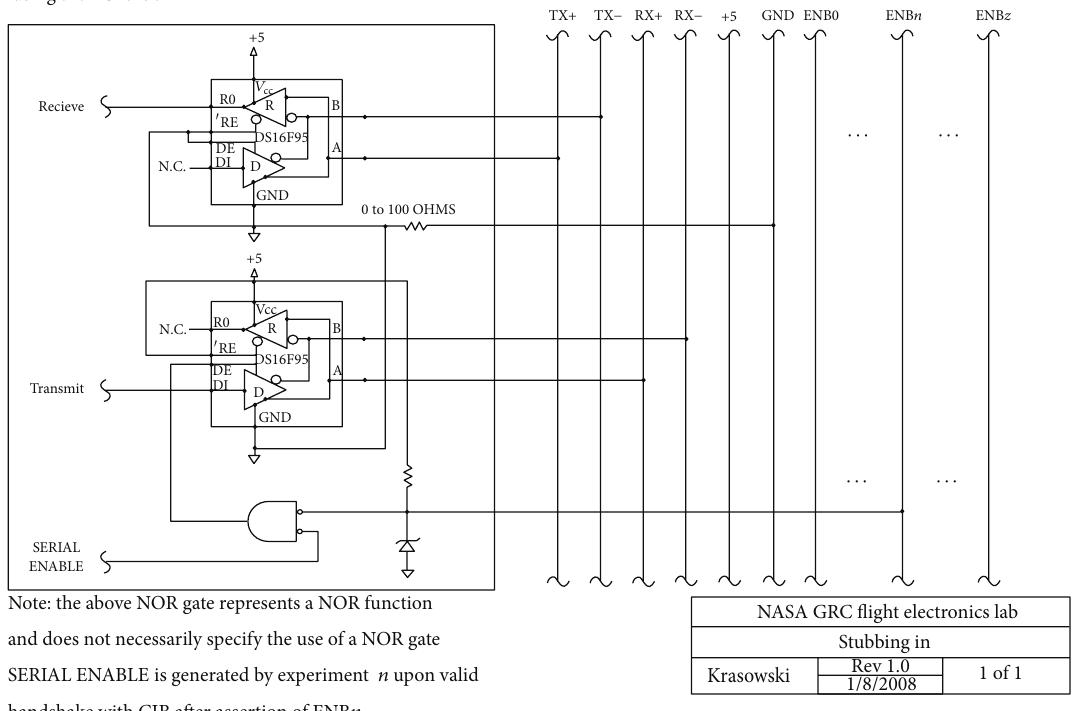
Figure3: Schematic diagramoftheRS-485businterfaceprovided toexperiments byCommunicationsInterfaceBoard(CIB)(imagecourtesy of